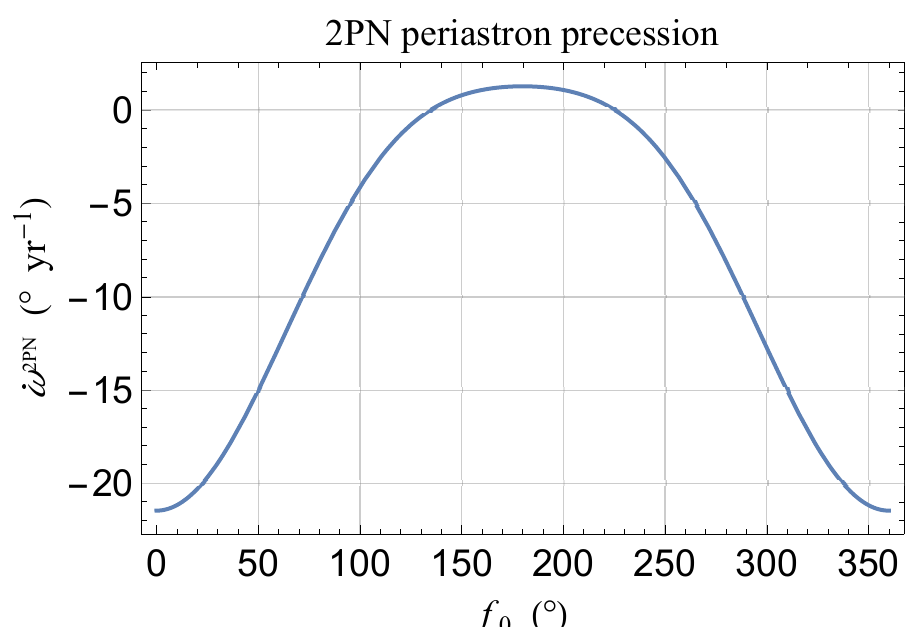
Figure 1. Upper panel: time-dependent signatures ∆ ω 2PN ( t ) (see text for details on their generation) obtained by numerically integrating 1PN + 2PN equations of motion for a fictitious two-body system with M A = 1 × 10 6 M (cid:12) , M B = 2 × 10 6 M (cid:12) , P b = 0.05yr, e = 0.75 for different values of true anomaly at epoch f 0 . Superimposed straight lines are linear fits to corresponding ∆ ω 2PN ( t ) . Units are ◦ . Lower panel: plot of 2PN periastron precession, in ◦ yr − 1 , analytically calculated for same binary system with Equation(18) as a function of f 0 .